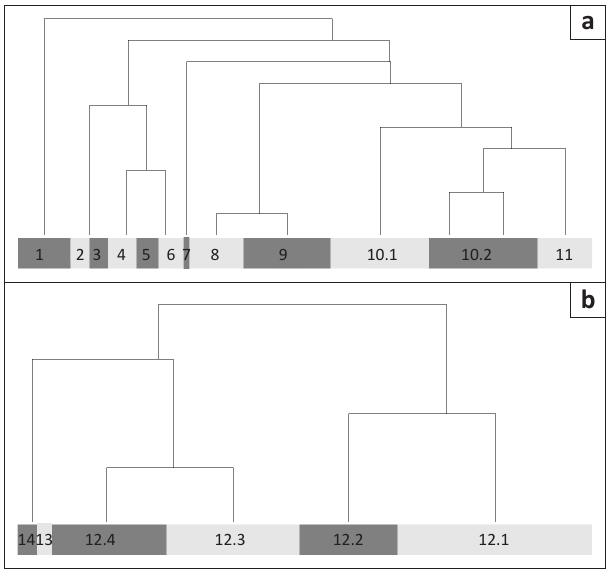
FIGURE 2: Dendrograms of the classification results of, (a) microphyll savannas and (b) broad-leaved savannas, also indicating refinements to certain clusters performed during data processing. The numbers correspond to the association numbers used in the text.